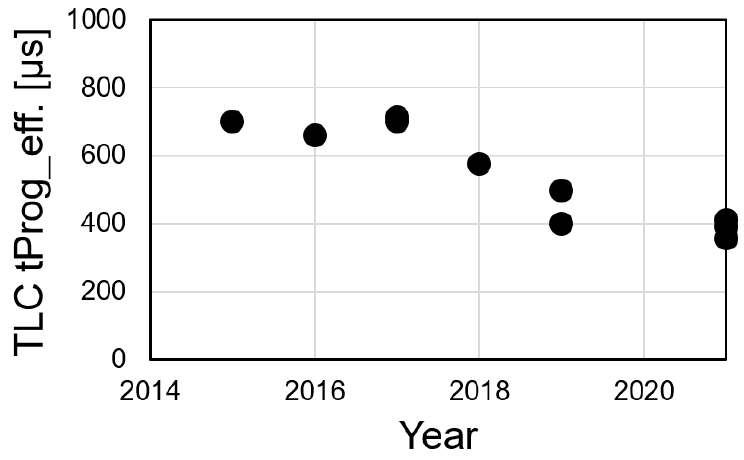
Figure 17. TLC effective tProg reported or calculated from ISSCC publications.